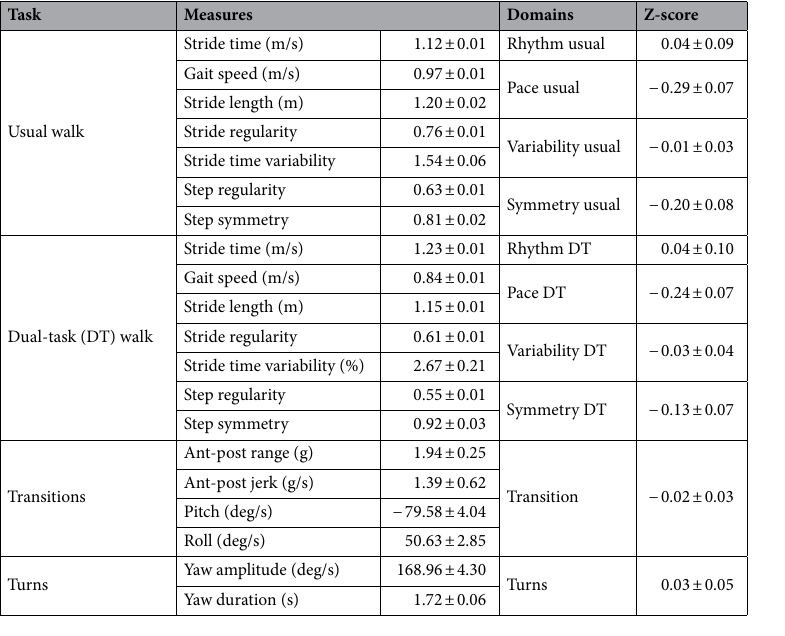
Table 1. The gait and mobility measures used to assess each task and their grouping into ten mobility